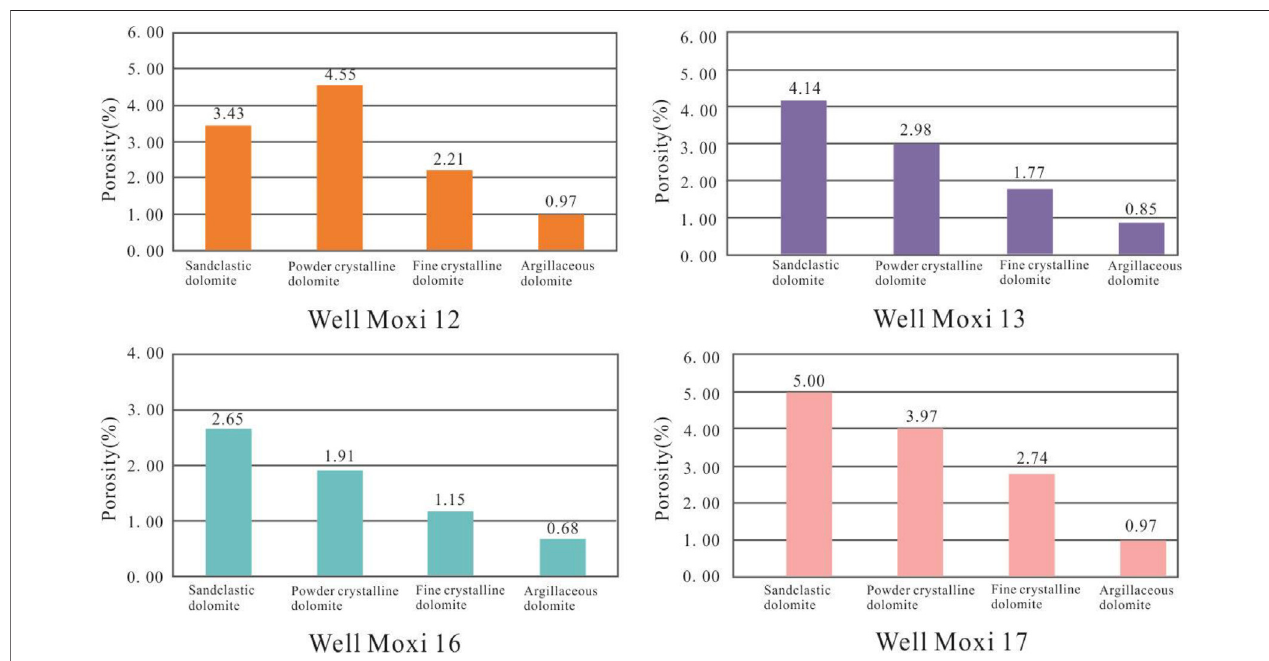
FIGURE 10 | The histogram of the relationship between lithology and porosity of the Longwangmiao Formation in the Sichuan Basin.